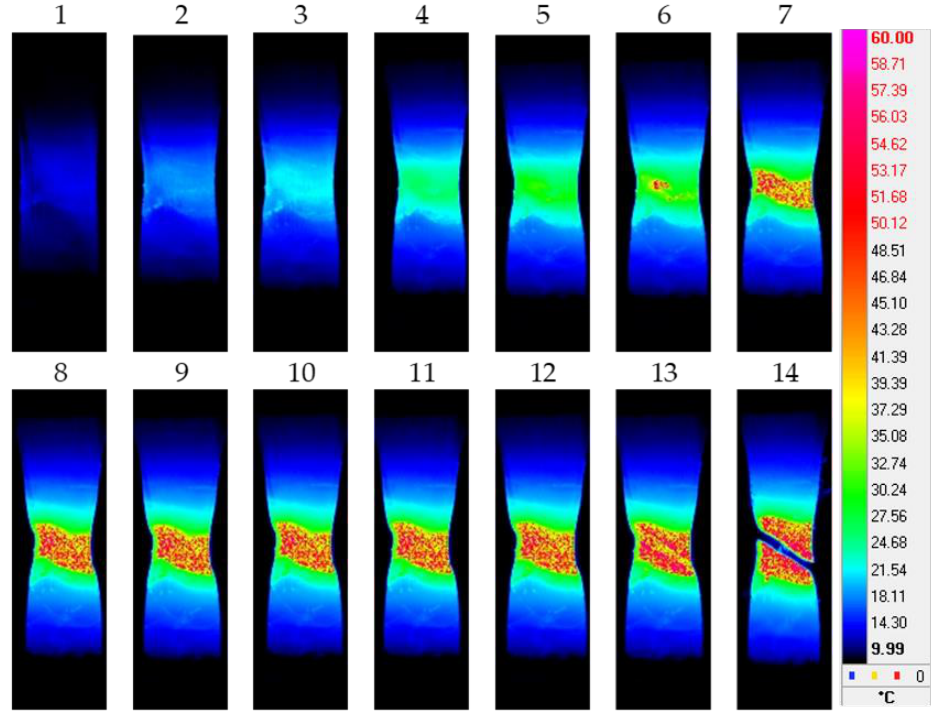
Figure 4. IR thermograms of deformed pure titanium sample in the UFG state: 1 — ε = 0.05; 2 — ε = 0.055; 3 — ε = 0.06; 4 — ε = 0.065; 5 — ε = 0.07; 6 — ε = 0.075; 7 — ε = 0.08; 8 — ε = 0.085; 9 — ε = 0.09; 10 — ε = 0.095; 11 — ε = 0.10; 12 — ε = 0.105; 13 — ε = 0.11; 14 — ε = 0.115.